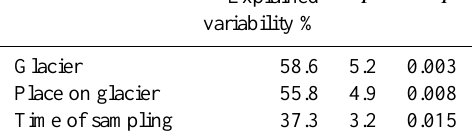
Table 6. Results for an RDA with spatial and temporal variables as explanatory factors and the explained variability in each variable on the final model. The glacier variable represents the three sampled glaciers.